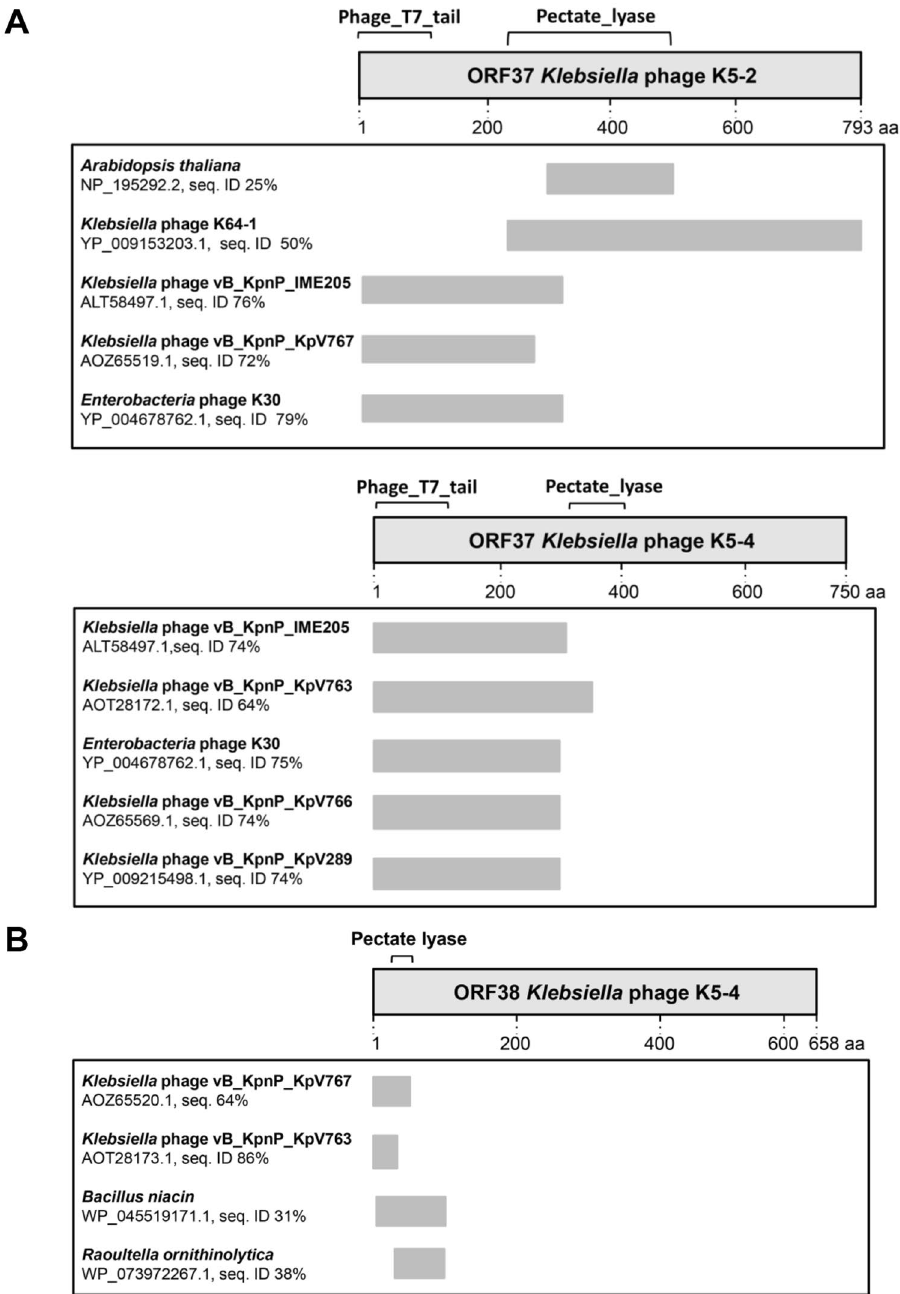
Figure 2. Bioinformatic analysis of Klebsiella phages K5-2 and K5-4. ( A ) NCBI SmartBLAST analysis of K5-2 ORF37 and K5-4 ORF37 proteins in non-redundant sequence database. ( B ) NCBI SmartBLAST analysis of K5-4 ORF38 protein in non-redundant sequence